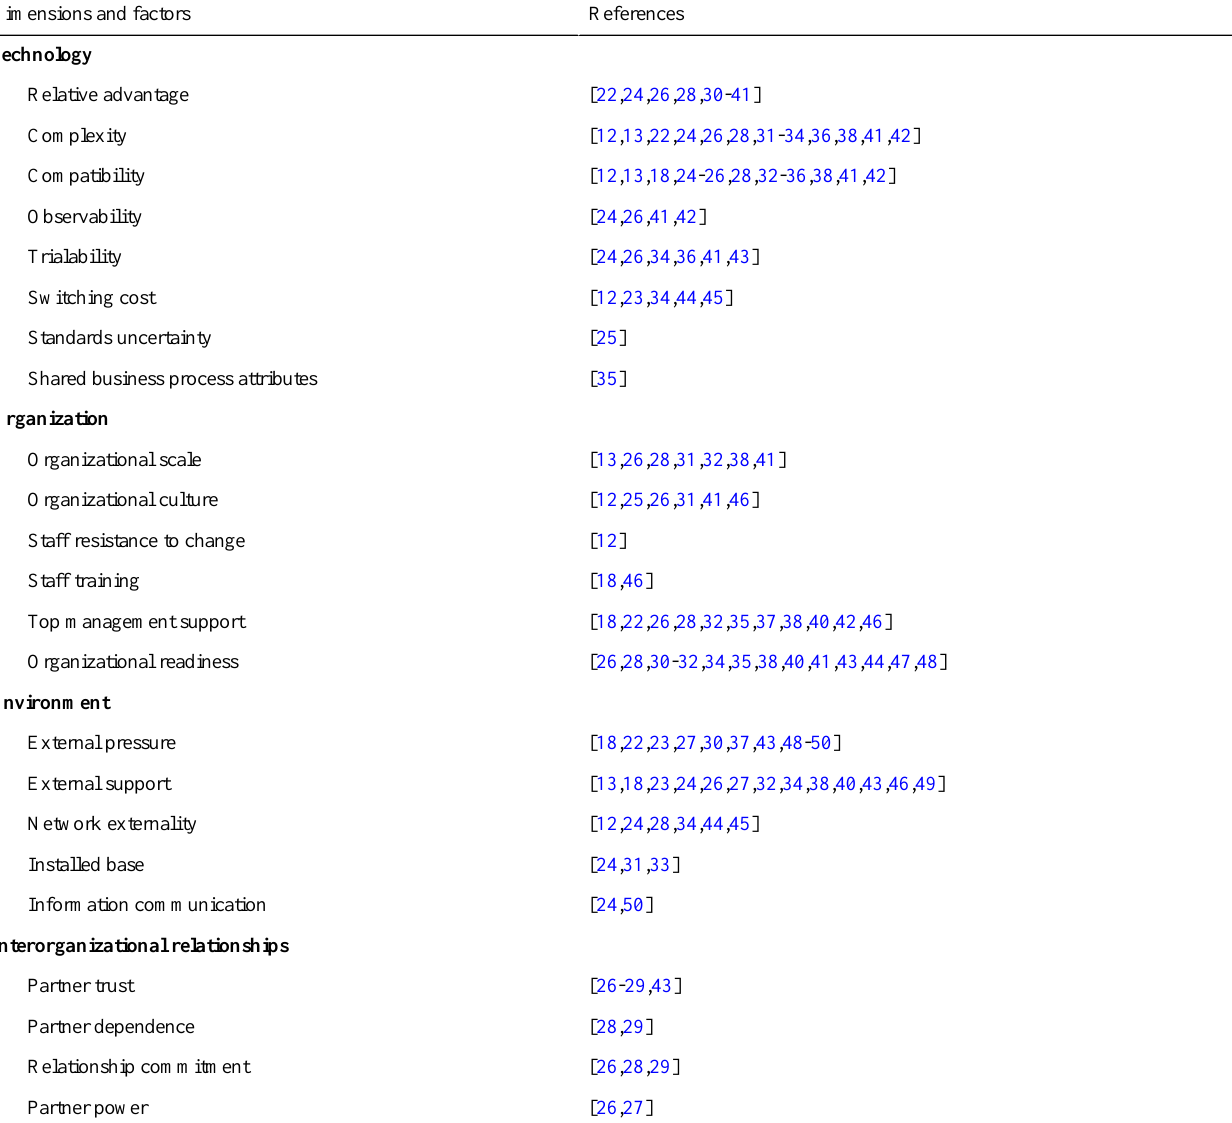
Table 1. Factors that influence the adoption of health information standards under the 4